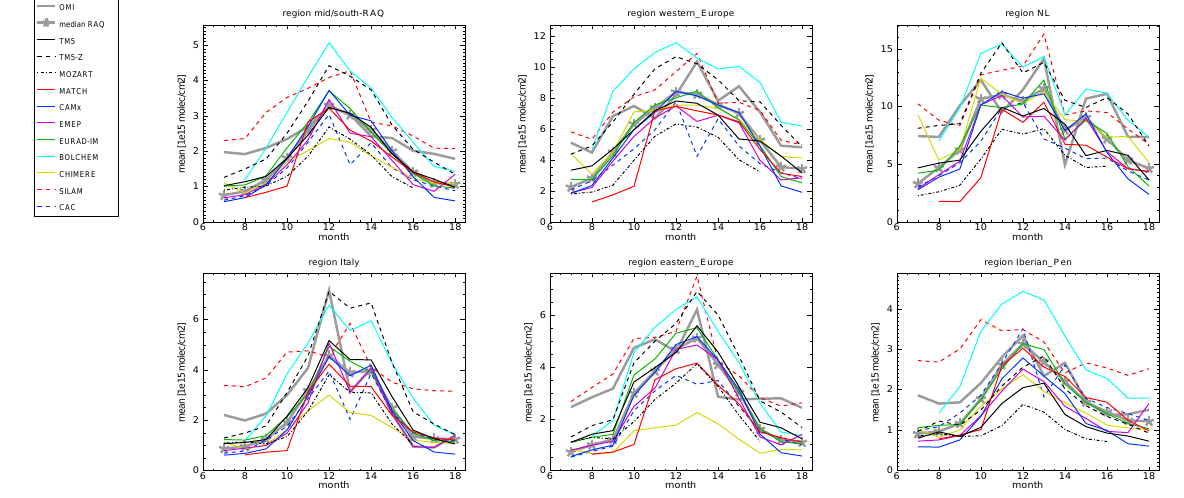
Fig. 6. Area-averaged monthly mean tropospheric NO 2 columns for selected regions, running from July 2008 (month 7) up to June 2009 (month 18). Table 5. Regression slope and offset in units 10 15 molec/cm 2 in August and December 2008 of the ensemble median and all indi- vidual models versus OMI over the mid/south RAQ